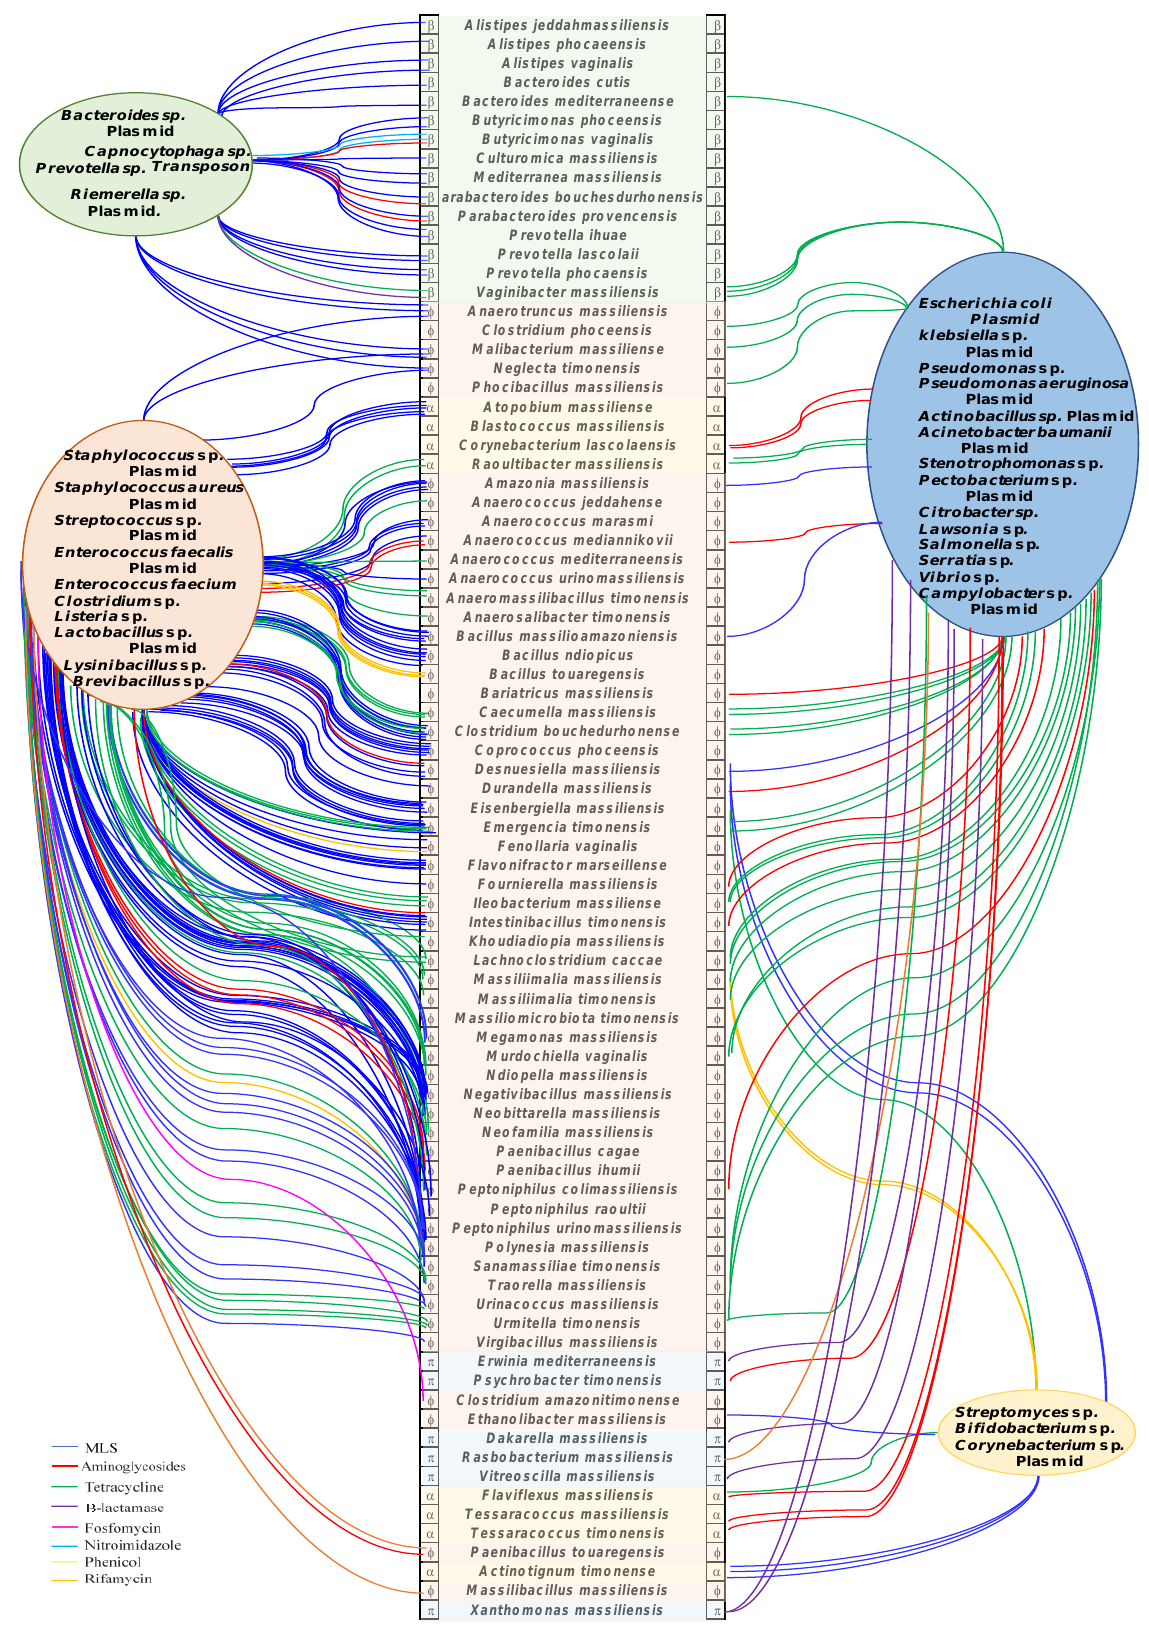
Figure 5. The melting-pot inside the human microbiota. Network showing possible horizontal transfers between the new species analyzed herein and commensal and pathogenic species from Bacteroidetes ( β ) , Firmicutes ( φ ) , Proteobacteria ( π ) and Actinobacteria ( α ). The edges were colored according to the antibiotic